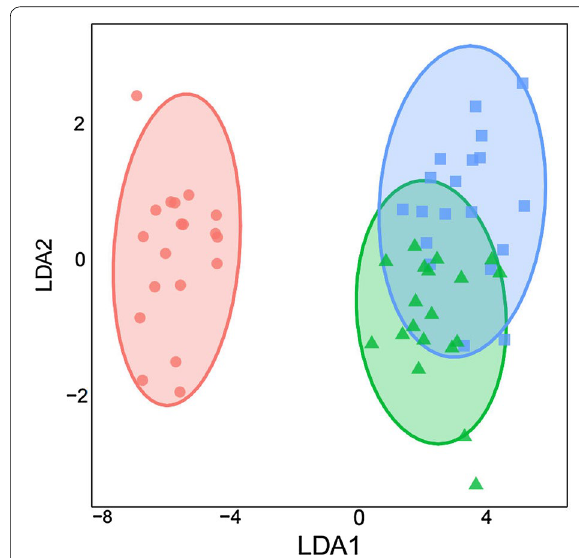
Fig. 6 Morphological variation in Blepharis populations from Jordan visualized along the first two linear discriminant (LD) axes, and calculated from Euclidean distances of 14 morphological characteristics measured on individuals from Kufranjah valley (northern population, blue squares), Dead Sea region (northern population, green triangles), and Wadi al Yutm (southern population, red